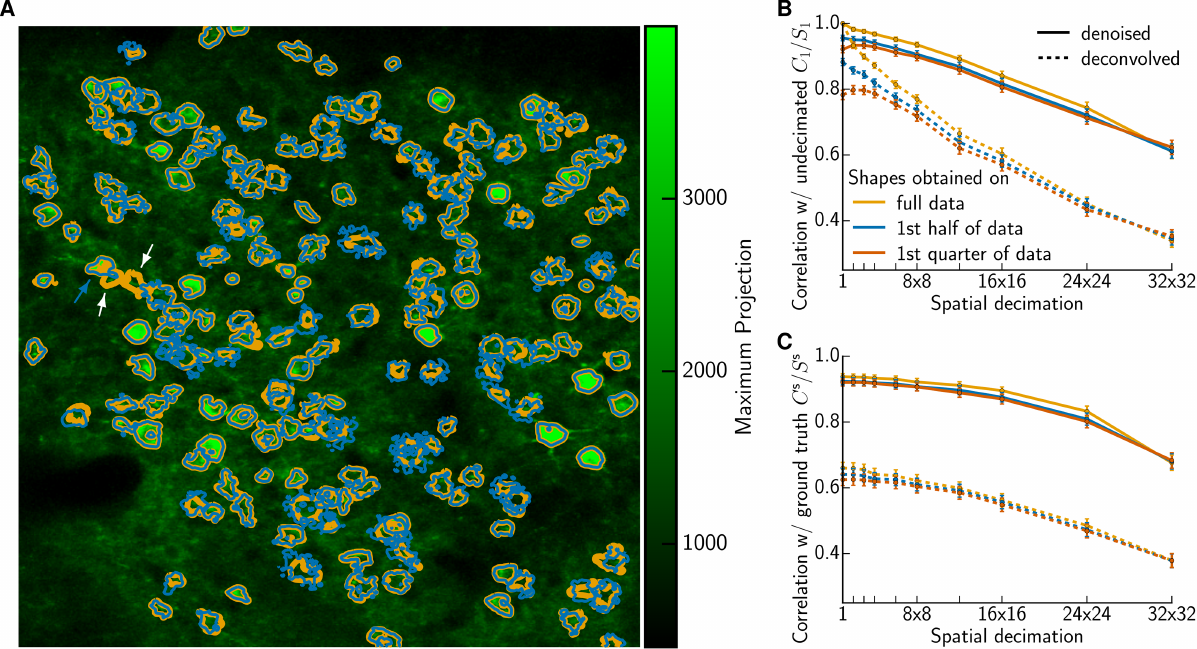
Fig 7. Estimating neural shapes on small initial batch of the data. (A) Shapes inferred on the full data (orange)or using only the first half (blue). Two apparently lost suspected ROIs (white arrows) are actually part of anotherneuron(blue arrow) (B) Average correlation( ± SEM) betweentraces C l obtained on decimateddata and the reference C 1 obtainedwithout any decimation. Similar results hold for medianand IQR, but the resultingplot is too cluttered. (C) Comparingto simulatedgroundtruth C s . Traces were obtainedon decimateddata with reshuffled residuals, otherwiseanalogousto